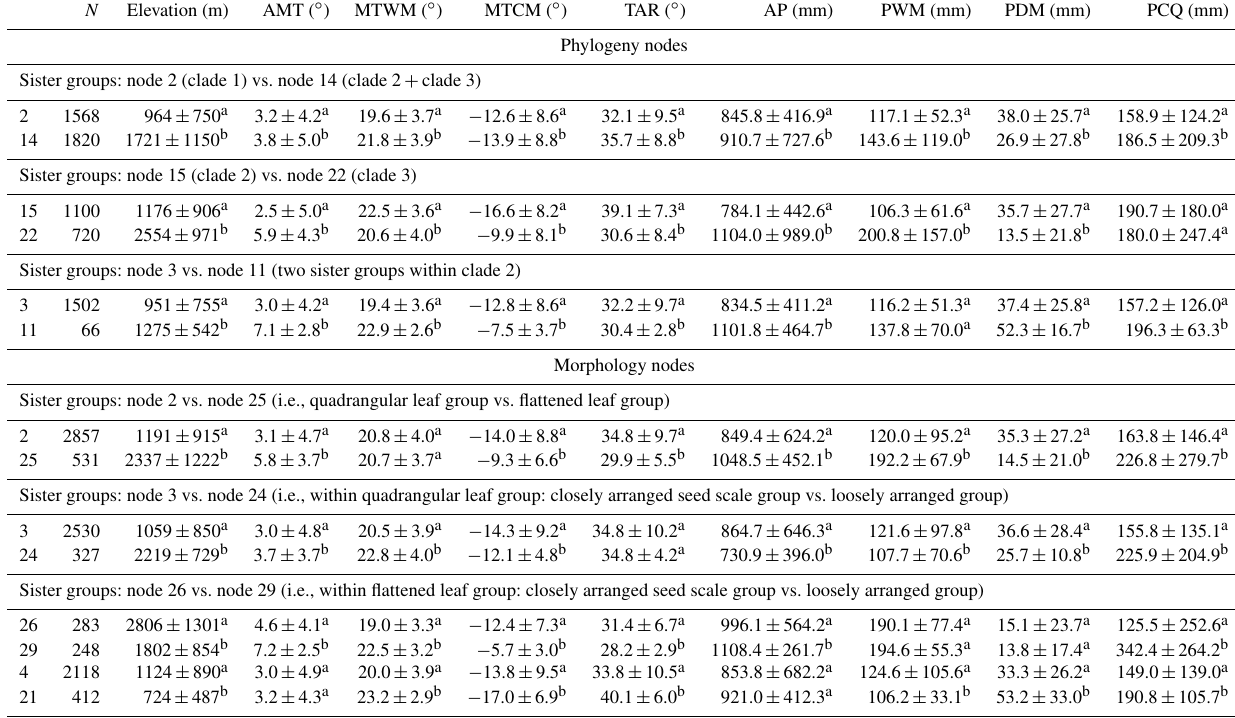
Table 2. Mean comparisons of the elevation and eight climatic variables (mean ± SD, abbreviations are the same as in Table 1) between sister groups at the first two split levels of both the phylogenetic tree and the morphological tree. Mean ± SD values marked with different letters indicate a significant difference at P < 0 . 05, and the same letter indicates a non-significant difference ( P > 0 . 05). N Elevation